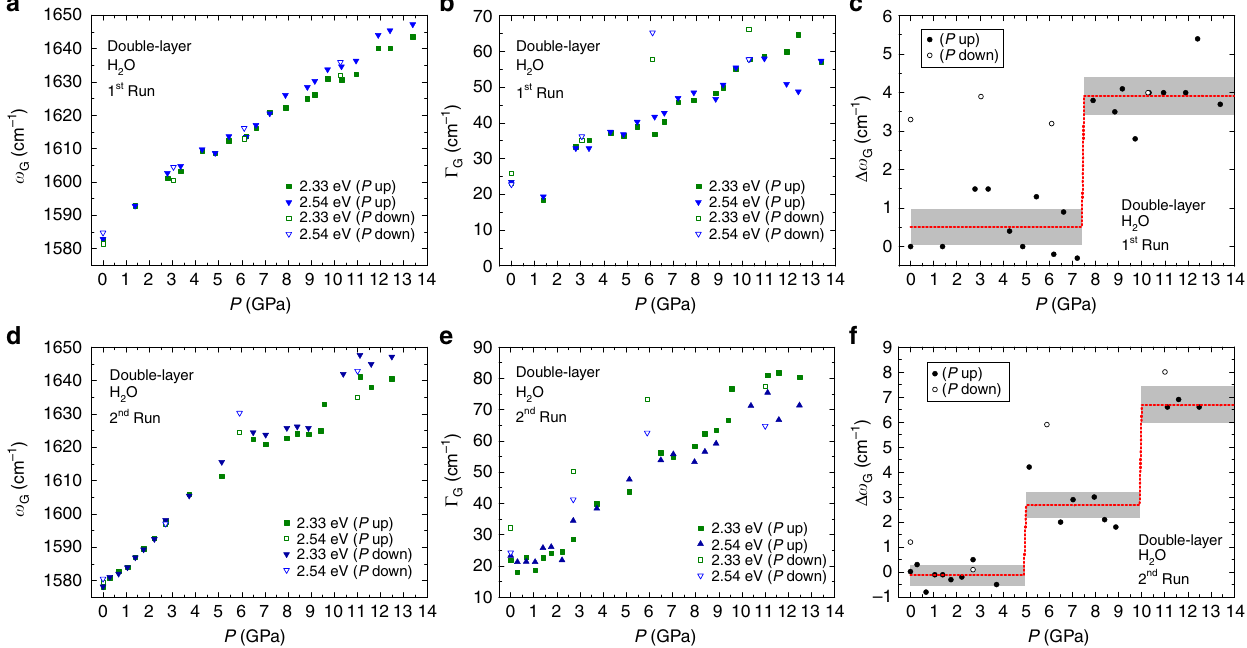
Fig. 2 Raman parameters as function of pressure. a – c and d – f show data extracted from the fi rst (spectra shown in Fig. 1b) and second (spectra shown in Fig. 1c) runs, respectively. Filled/empty symbols correspond to data obtained during pressure increase/decrease. a , d G band frequency ( ω G ) as a function of the pressure ( P ). b , e G band width ( Γ G ) as a function of P . Green and blue symbols in panels a , d and b , e are applied for data taken with E L = 2.33 and 2.54 (cid:2) ω green eV, respectively. c , f Plot of the difference Δ ω G ¼ ω blue as a function of P , where ω blue and ω green are the G-peak central frequencies obtained with G G G G E L = 2.54 and 2.33 eV, respectively. The dashed-red line is a step-function fi t to the experimental data, and the gray areas delimit the 95% con fi dence intervals of the fi tting